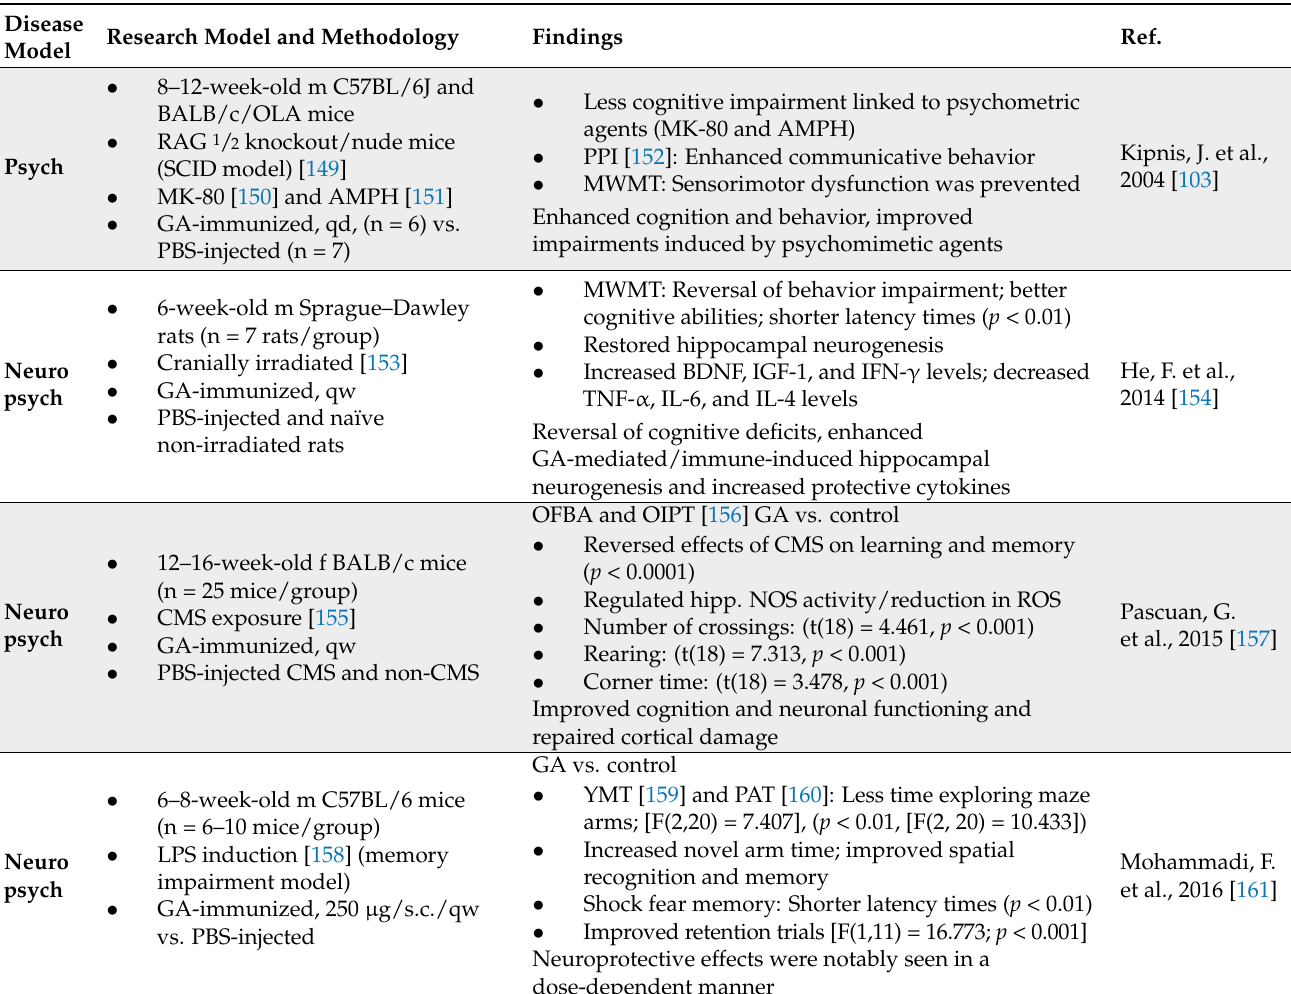
Table 9. Animal Studies Examining Alternative Uses of Glatiramer Acetate in Neuropsychology. Disease